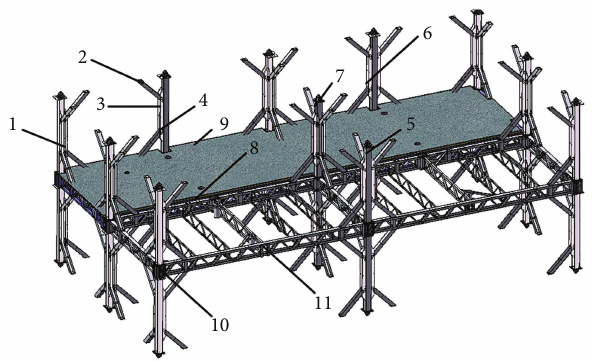
Figure 1: Modularized prefabricated steel frame structure with inclined braces. 1: column; 2: inclined brace; 3: column stiffening ribs; 4: single-side brace column; 5: three-side brace column; 6: double-side brace column; 7: four-side brace column; 8: hanging box; 9: main floor; 10: column base; and 11: truss.